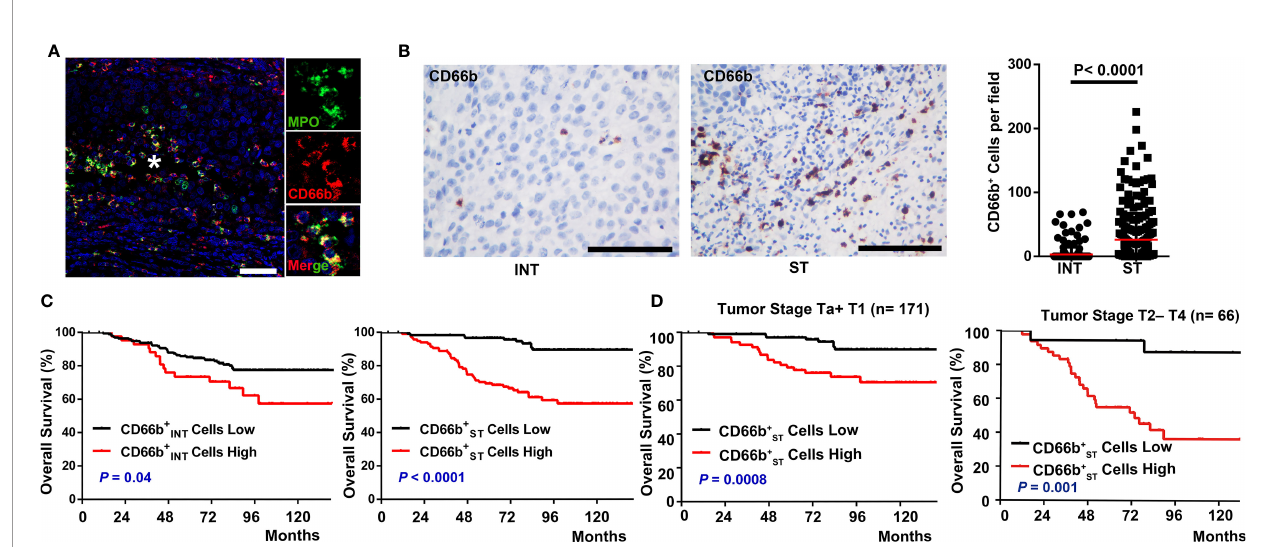
FIGURE 1 | Spatial distribution of neutrophils and prognostic signi fi cance of their density with overall survival in UCB patients. (A) Paraf fi n-embedded UCB sections were subjected to two-color immuno fl uorescence staining for CD66b (red) and MPO (green). * marked the magni fi ed fi eld. Scale bar: 20 m m. (B) Distribution of CD66b + in the intratumoral (INT) and stromal (ST) regions of UCB tissues (n = 237). Scale bar: 100 m m. Cell numbers were calculated as the cell count per 400× fi eld. Data are expressed as the means ± SEM. (C) Cumulative overall survival curves of the patients. Patients were divided into two groups according to the median number of CD66b + cells per 400× fi elds, including CD66b + INT cells in INT regions (CD66b + INT cells, median = 0 cell/ fi eld), CD66b + cells in ST regions (CD66b + ST cells, median = 5 cell/ fi eld). (D) Kaplan-Meier overall survival curves strati fi ed by tumor stage. NMIBC (non-muscle-invasive bladder cancer, tumor stage Ta+T1, n = 171) and MIBC (muscle-invasive bladder cancer, tumor stage T2-T4, n = 66); Kaplan-Meier survival estimates and log-rank tests were used to analyze the prognostic signi fi cance of these cells. Black lines, low group; red lines, high